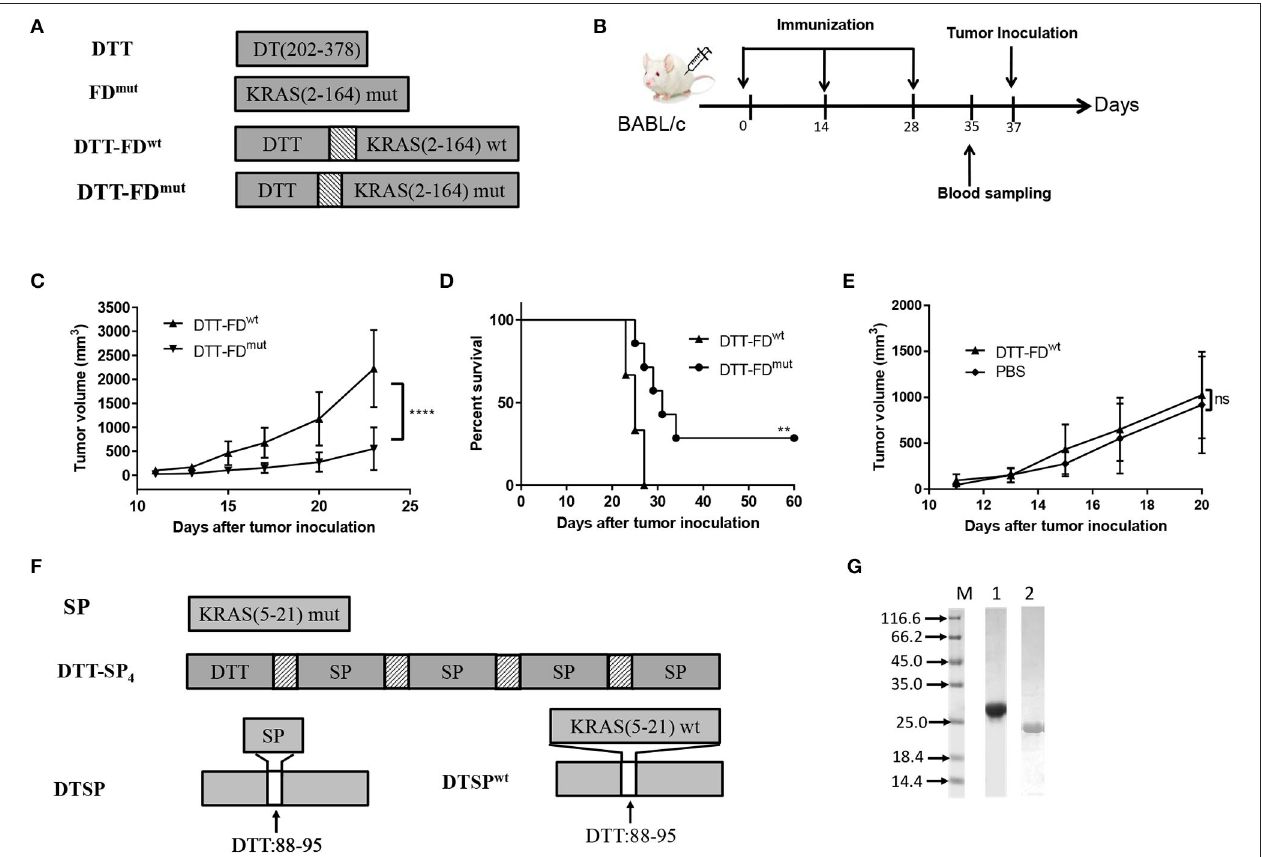
FIGURE 1 | Rationally designed mutant peptide-based vaccines. (A–E) Contributions of mutated and non-mutated epitopes to Anti-Tumor efficacy were determined when DTT was used as a carrier protein. (A) DTT is the diphtheria toxin T-domain, corresponding to amino acids 202–378 of DT. FD mut represents KRAS G domain (residues 2–164) carrying the G12D mutation. DTT-FD mut and DTT-FD wt were constructed by fusing KRAS G domain (residues 2–164) to the C-terminal of DTT through a GS linker. DTT-FD mut and DTT-FD wt represent presence and absence of KRAS G12D mutation, respectively, in the fusion construct. (B) Flow chart of immunization and tumor inoculation. (C–E) DTT-FD mut , DTT-FD wt , and PBS were separately formulated in Alum and CpG. Female BALB/c mice ( n = 5–8) received the formulated vaccines three times at 2-week intervals. Mice were injected with 2 × 10 5 cells/mouse 10 days after the last immunization. (C) Tumor growth curves of DTT-FD mut and DTT-FD wt were plotted by averaging tumor size over time in each group. Data are presented as means ± SD. **** p < 0.0001, Student’s t -test (D) Kaplan–Meier survival curve. ** p < 0.01, ns, not significant, log-rank (Mantel–Cox) test for significance. (E) Tumor growth curves for DTT-FD wt and PBS. Data are plotted as means ± SD. ns, not significant. (F,G) Design and purification of mutant peptide-based vaccines. (F) Schematic representation of DTT-SP 4 and DTSP. SP represents residues 5–21 of KRAS containing the G12D mutation. DTSP wt represents wild-type DTSP lacking the KRAS G12D mutation. The texture box stands for the linker sequence (GG). The white box denotes the position of DTT from 88 to 95 replaced with SP. (G) Expression levels of DTT-SP 4 (lane 1) and DTSP (lane